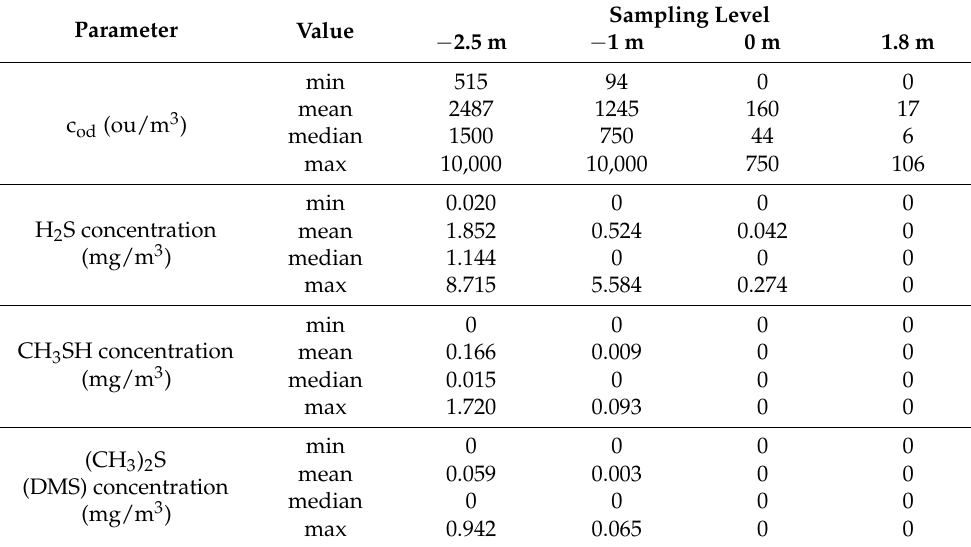
Table 3. Values of minimum, average, median, and maximum results of odour and selected odorant concentrations at test points at different depths from under the manholes to the sewers. Depths: 2.5 m, 1 m, at the level of the manhole, and at the height of 1.8